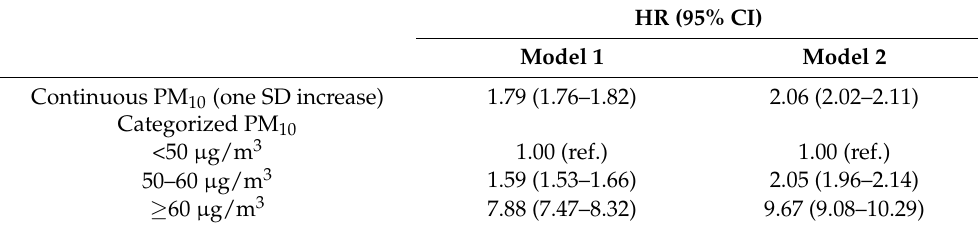
Table 2. HRs for all-cause mortality by continuous and categorized PM 10 exposure.